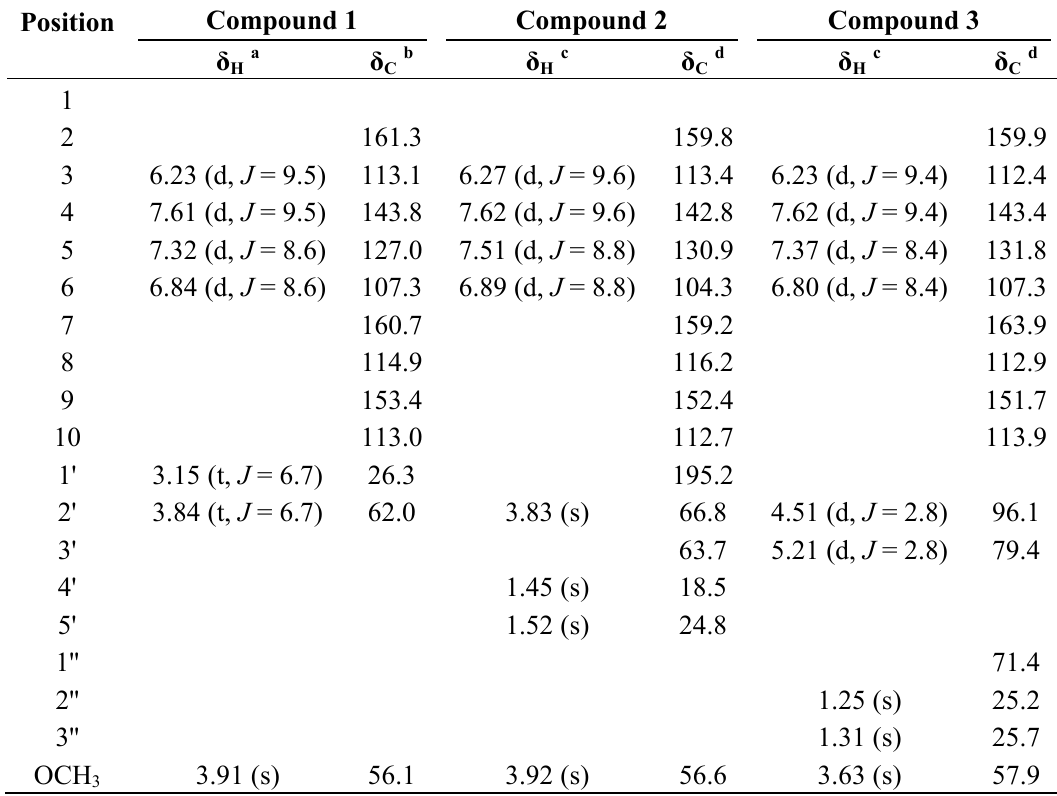
) of compounds 1 – 3 . δ in ppm, J in 3